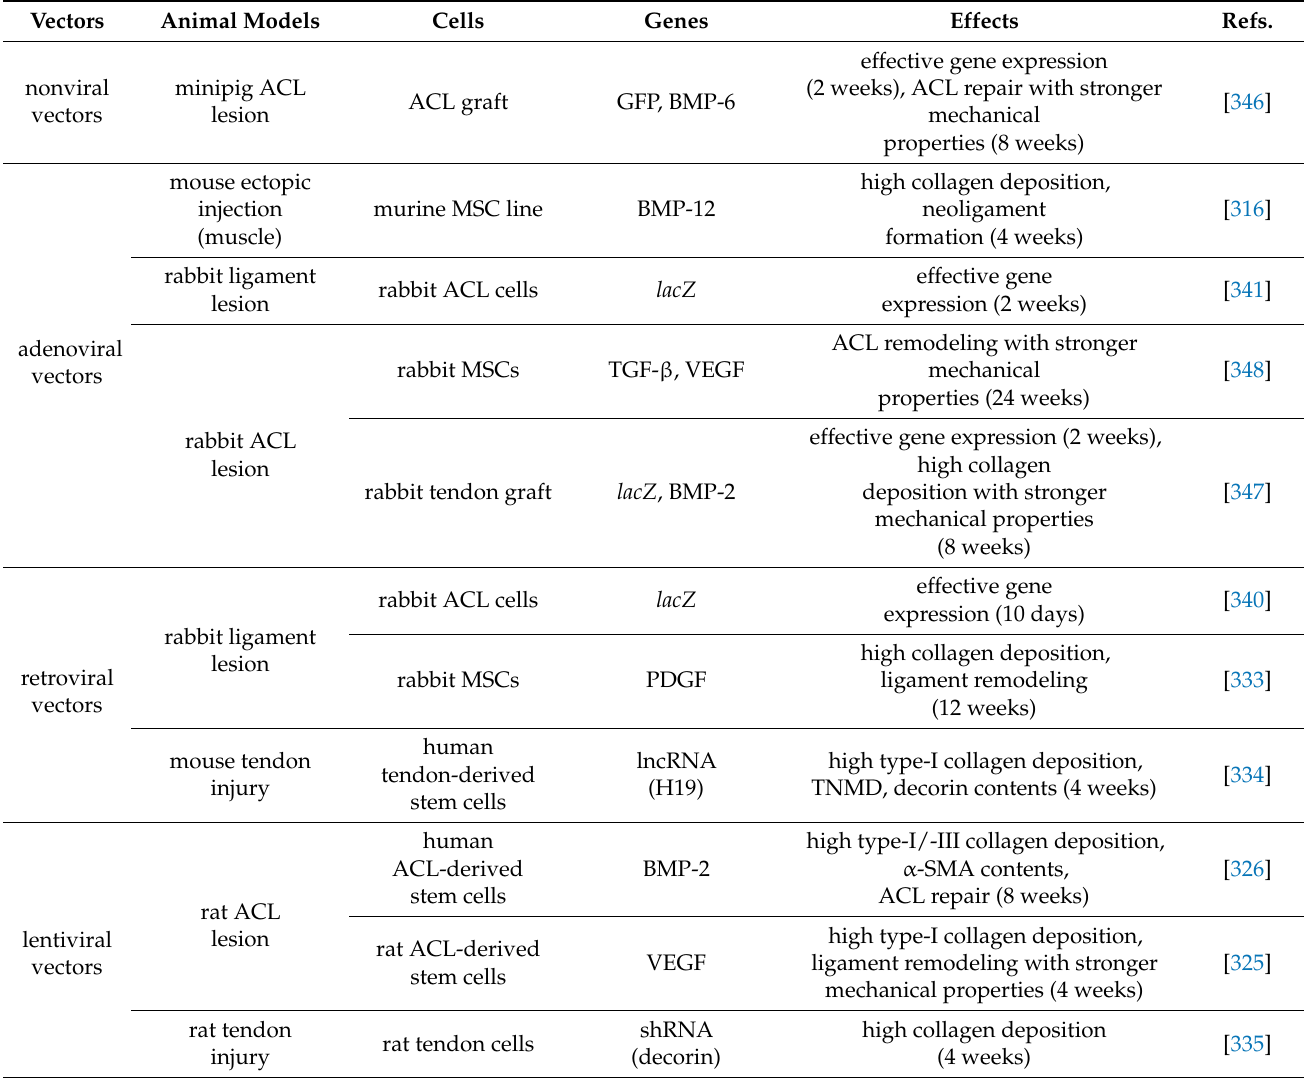
Table 5. Applications of classical gene therapy for indirect ACL repair ex